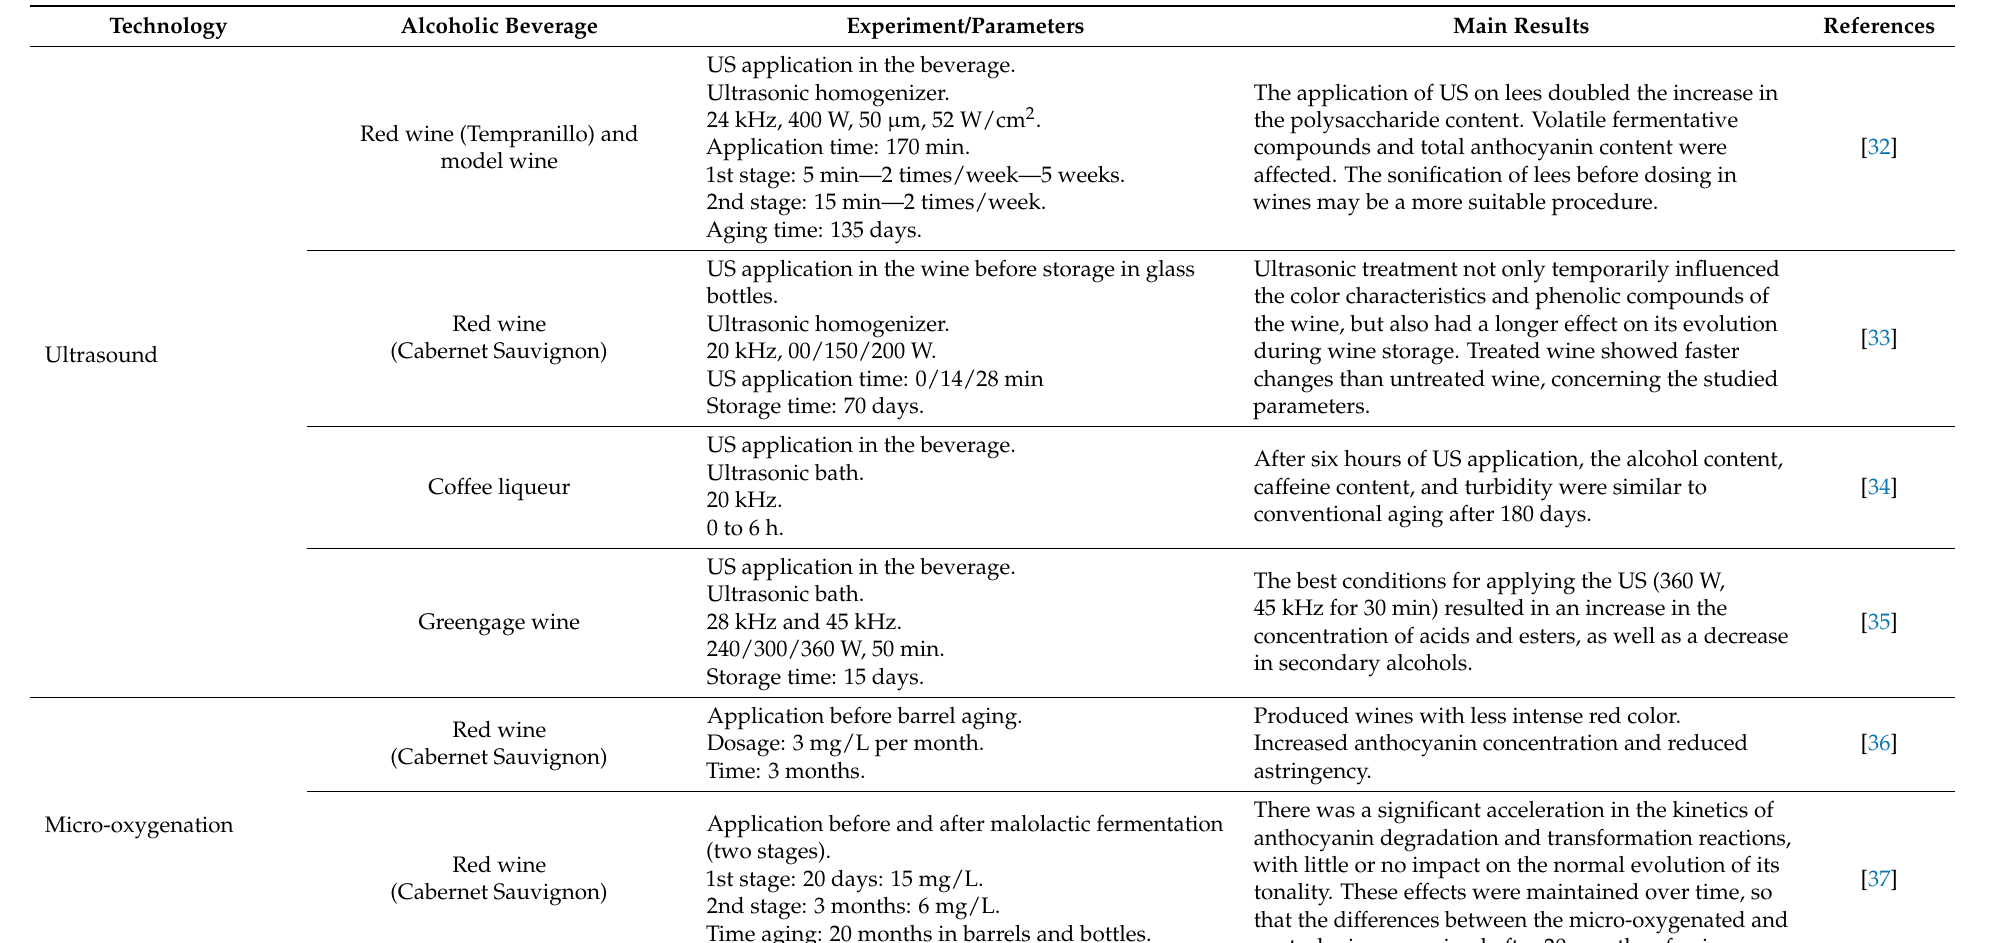
Table 2. Research regarding the application of alternative technologies in the aging of